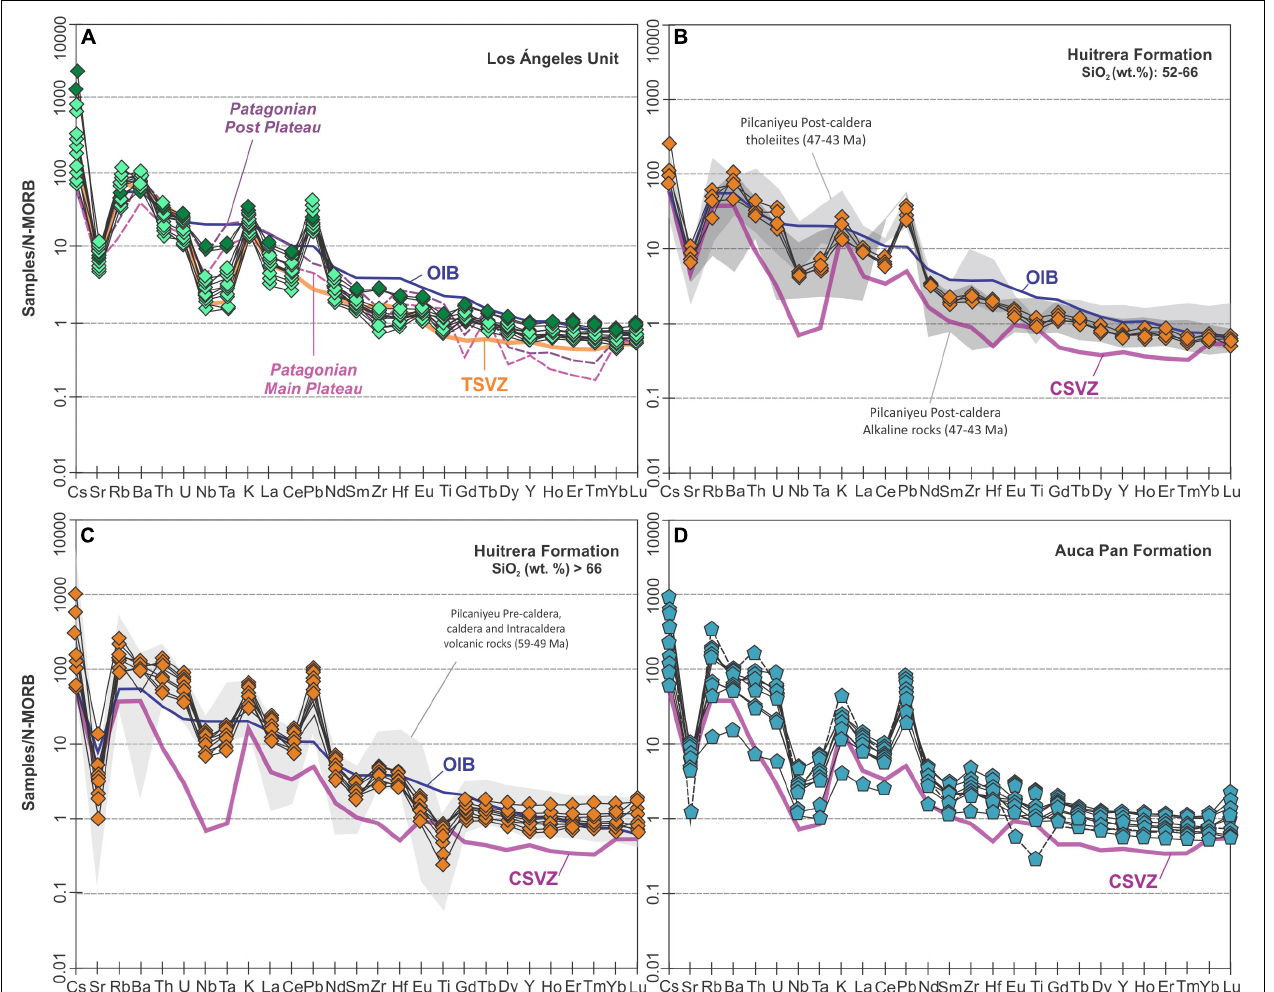
FIGURE 5 | (A) Multi-element diagram for the Late Cretaceous Los Ángeles Unit. (B,C) Multi-element diagrams for intermidiate and acid volcanic rocks of Huitrera Formation, respectively. (D) Multi-element diagram for the Auca Pan Formation. Geochemical data of the studied sequences are taken from Iannelli et al. (2017, 2018). Average of TSVZ (34.5–38 ◦ S) corresponds to Futa and Stern (1988); Hickey-Vargas et al. (1986), Ferguson et al. (1992); Wehrmann et al. (2014), and Jacques et al. (2013). The average of the CSVZ (38–43 ◦ S) corresponds to Mella et al. (2005); López-Escobar et al. (1992)López-Escobar et al. (1995); Deruelle (1982), and Wehrmann et al. (2014). The average of the OIB composition is from Sun and McDonough (1989), while the geochemical data for Pilcaniyeu pre-, intra-, and post-caldera stages are from Aragón et al. (2011). Patagonia Main and Post plateau data correspond to the Neogene back-arc magmatism presented by Gorring and Kay